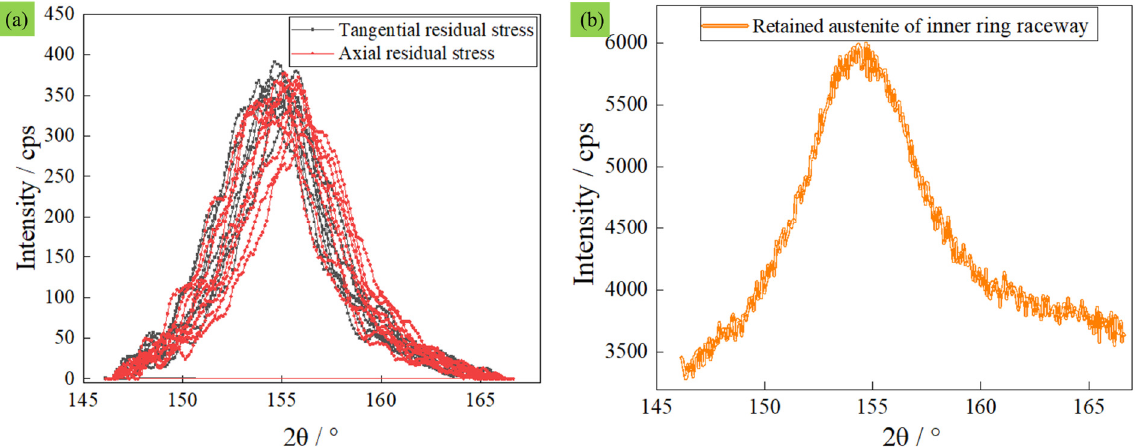
Figure 13. Scanning peak intensity of residual stress and retained austenite in a bearing’s inner-ring raceway. ( a ) Scanning peak intensity of residual stress. ( b ) Scanning peak intensity of retained austenite.